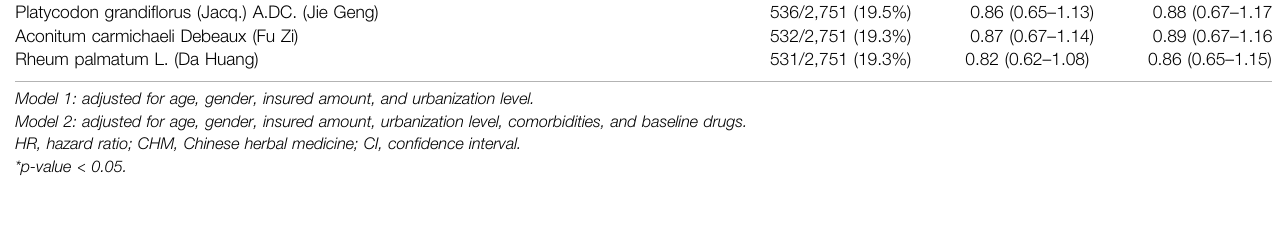
TABLE 5 | Hazard ratios of cardiovascular disease for the top 10 frequently used polyherbal formulas in comparison with the matched non-CHM groups. Polyherbal formulas